Question: In one sentence, what is this figure communicating?
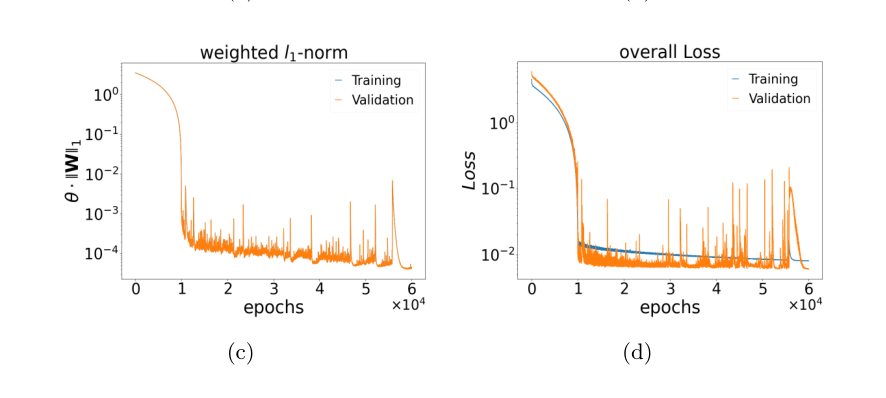
Answer: Weighted components of overall losses for phenotypes tolerant versus susceptible across domain experiment: (a) - reconstruction errors, (b) - classification errors, (c) - sparsity loss, (d) - overall loss.